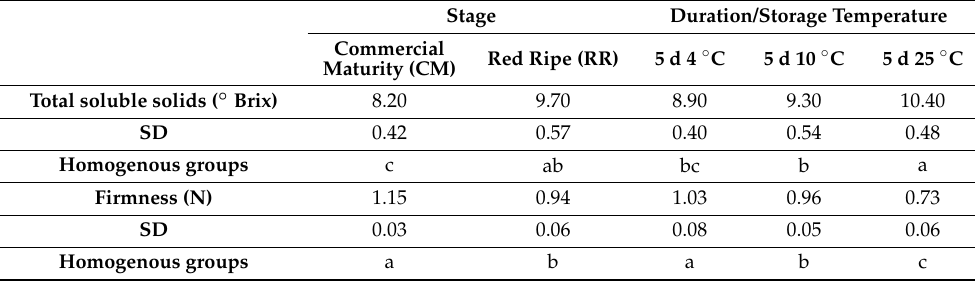
Table 1. Total soluble solids and firmness of tomato fruits (cv Chondrokatsari) during their late maturation and after postharvest storage (5 d) at different temperatures (4, 10 and 25 ◦ C). Significant differences between treatments were determined by one-way ANOVA and false discovery rate correction (FDR) ( p <